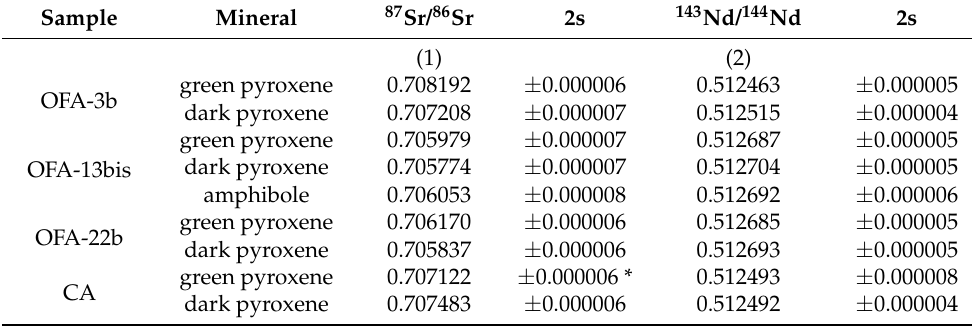
Table 1. Sr- and Nd-isotope